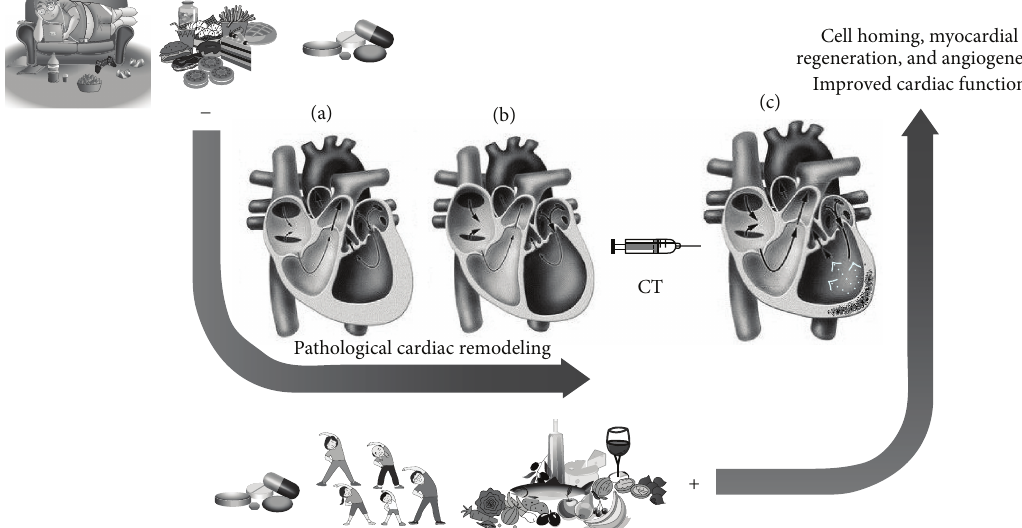
Figure 1: Factors that can modulate the cardiac regeneration in association with the stem cell therapy. The sedentary lifestyle and unhealthy dietary habits (as diets with elevated levels of fat and sugar) characterize risk factors that may contribute to the development of heart diseases, mainly due to the triggering of harmful issues that arise from the ischemic process which is generated in consequence of these behaviors. Therefore, the ischemia activates pathological cardiac remodeling mechanisms, the results of which may be the hypertrophy (a) or dilation (b) of the ventricular muscle, and both contribute to a decrease in ventricular ejection function. In an attempt to control the disease, there are commonly prescribed drugs that may interfere with mechanisms of cell proliferation and differentiation. These combined habits may adversely influence the effectiveness of cell therapy (CT). Subsequently, protocols that use stem cells are poorly effective in the regenerative process. Drugs that stimulate the antioxidant properties and control the inflammatory response, as well as the practice of physical activity and diets rich in cardioprotective elements (PUFAs, antioxidants, etc.), may balance the immune system. Besides that, a decrease in the ROS demand and increase of angiogenesis are stimulated by these approaches, providing a better environment for cell homing activation. This scenario intensifies mechanisms for cell regeneration and may lead to an increase in myocardial perfusion and improvement of the cardiac function (c). Thin black arrows indicate the blood flow in normal or damaged heart situation. White arrows suggest the improvement of the global contractility in the left ventricle after the regeneration process by stem cell enforcement (the figure was made from publicly available